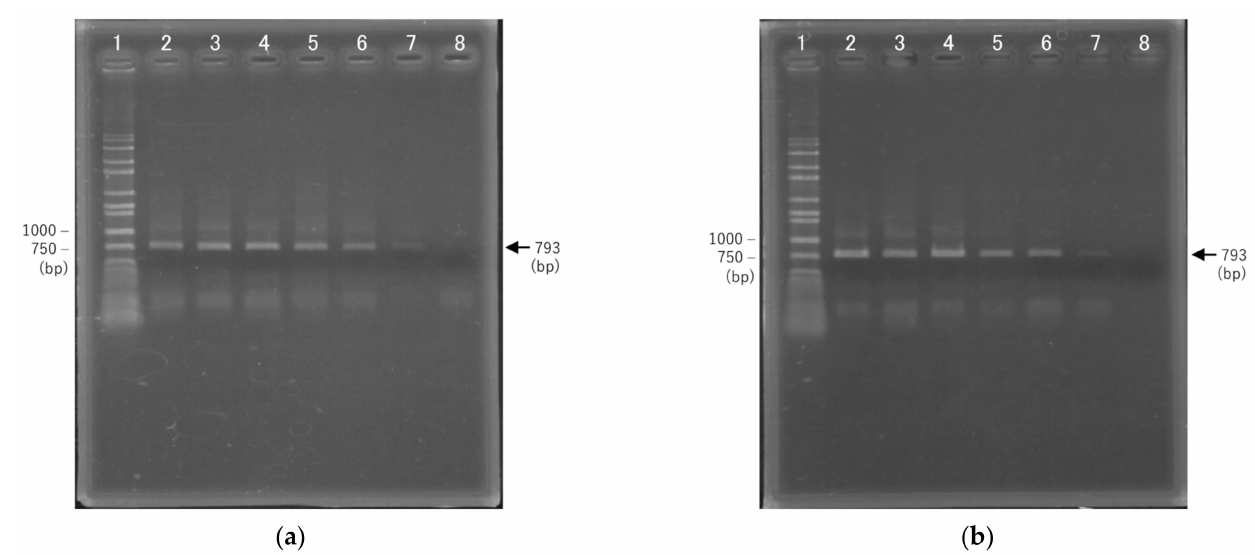
Figure 4. Results of 1% agarose gel electrophoresis of amplification products following 45 cycles of PCR using two DNA polymerases. ( a ) SpeedSTAR DNA HS Polymerase; 1: wide range DNA ladder, 2: 18 s, 3: 16 s, 4: 14 s, 5: 12 s, 6: 10 s, 7: 8 s, 8: 6 s. 2–8 indicate the annealing and extension durations. ( b ) KOD One polymerase; 1: wide range DNA ladder, 2: 16 s, 3: 14 s, 4: 12 s, 5: 10 s, 6: 8 s, 7: 6 s, 8: 4 s.